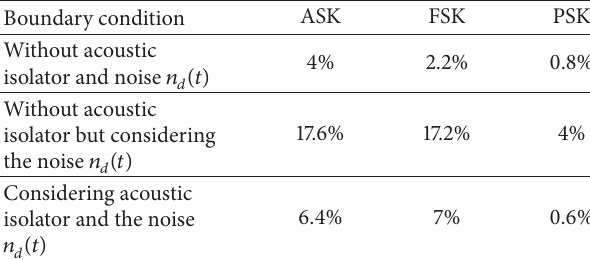
Table 2: The average BER for three basic modes of modulation. Boundary condition